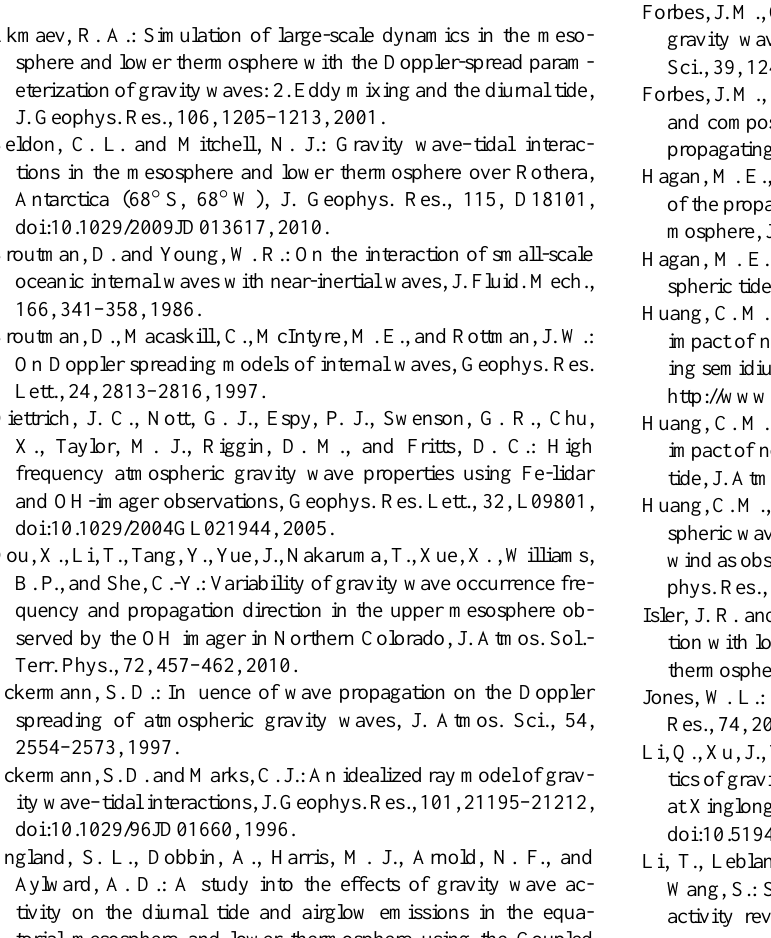
Fig. 8. Height and time variations of the ground-based GW frequency (solid curves) and the tidal horizontal-wind acceleration (dotted curves) for case F.